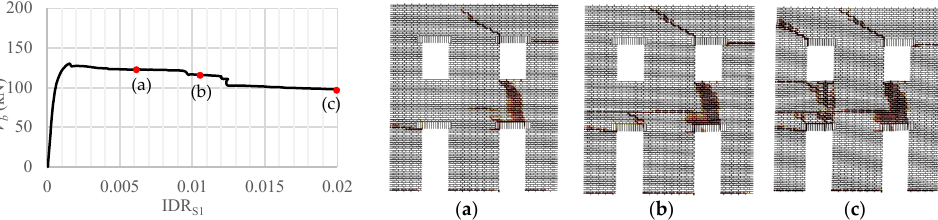
Figure 6. Cracking pattern of the masonry wall with VL-a. From left to right, damage scenarios corresponding to ( a ) 0.5%, 1% ( b ), and 2% ( c ) of IDR S1 .